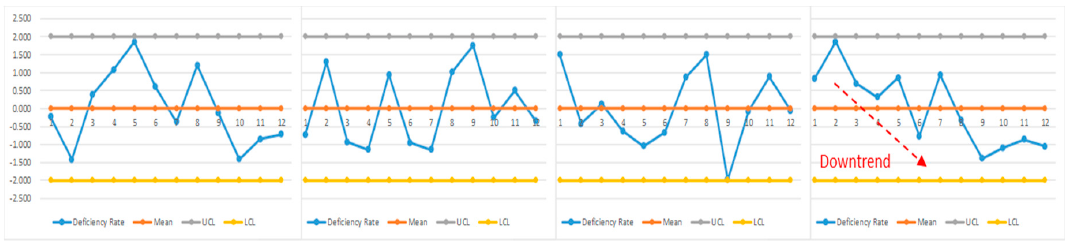
Figure 10. The control chart for deficiency 04 (2015–2018).